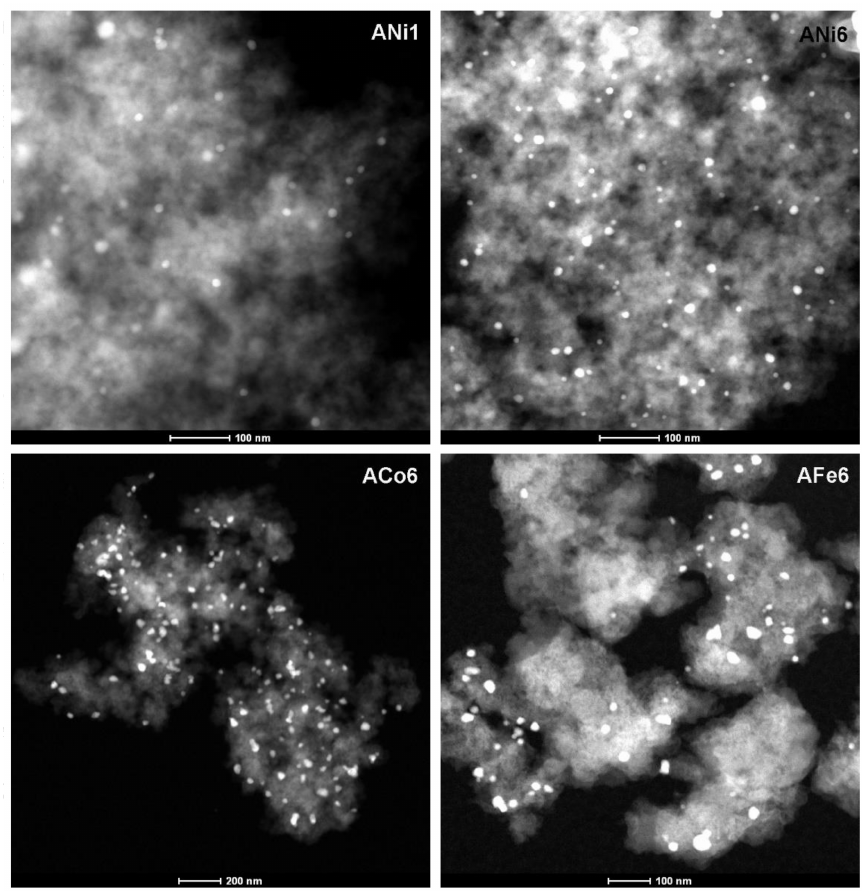
Figure 3. AEM spectra collected in STEM mode using a HAADF detector of the samples ANi1, ACo6, ANi6 and AFe6.